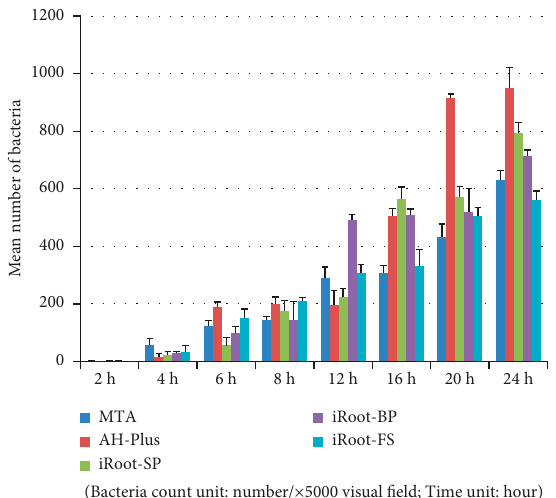
Figure 11: Enterococcus faecalis group (electron microscopy